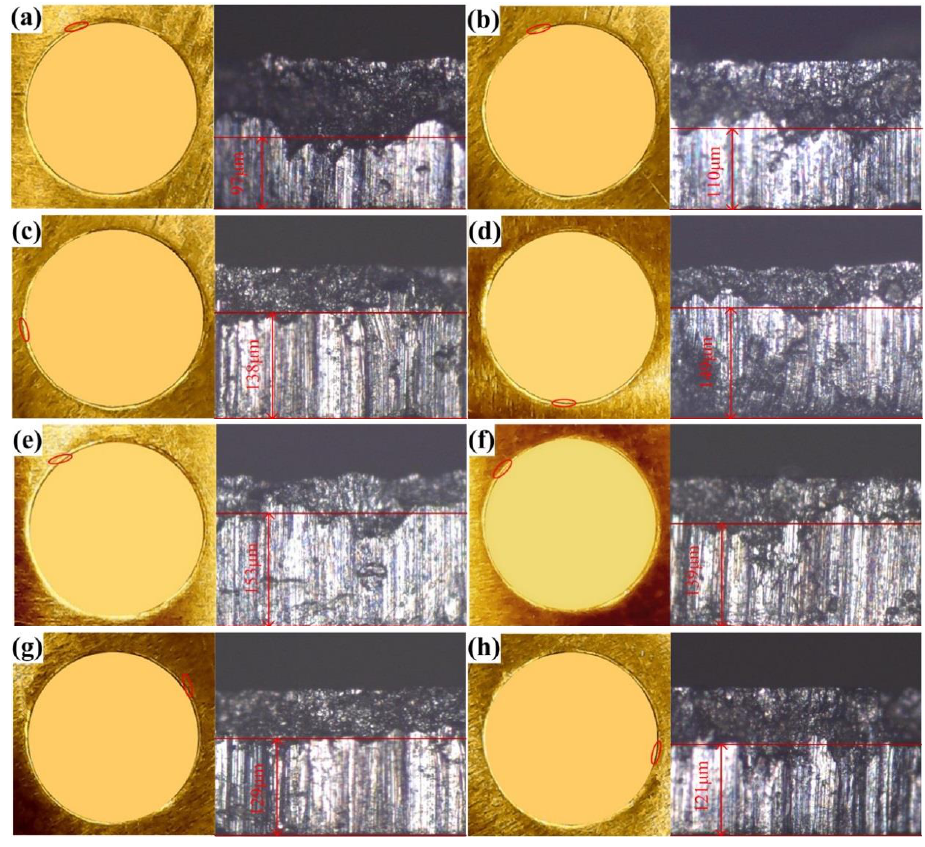
Figure 9. Diagrams of blanking fracture surface: ( a ) untreated; ( b ) AT; ( c ) ACT1; ( d ) ACT2; ( e ) ACT3; ( f ) ACT4; ( g ) ACT5; and ( h ) ACT6.